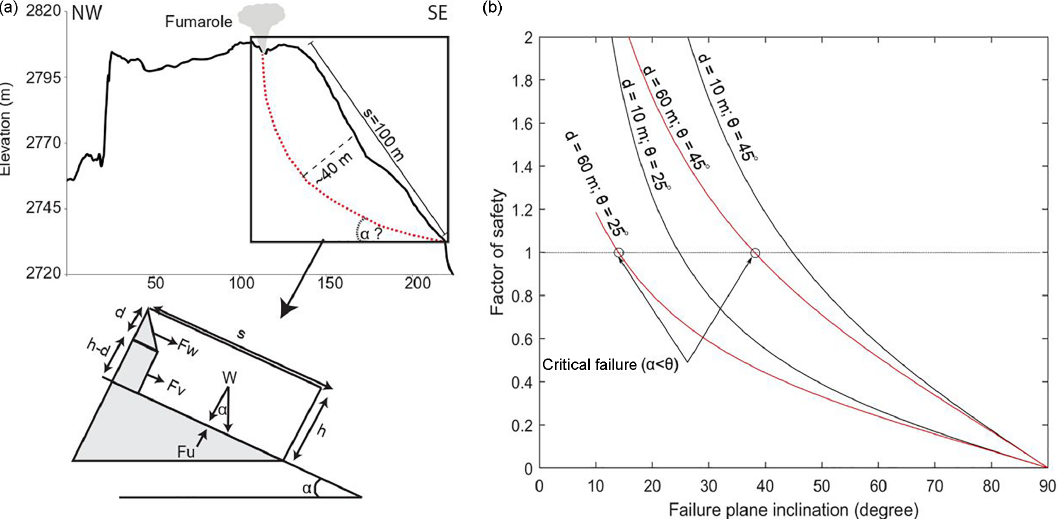
Figure 7. (a) Cross section of the Merapi lava dome shows that the horseshoe-shaped structure may develop into a translational fault with fracture spacing ( s ) up to 100m and a hanging wall thickness of ∼ 40m. The stability of the unstable dome sector is influenced by the weight ( W ), water force ( F W ), vaporized water force ( F V ) and gas uplift force ( F u ) along the fault boundary during intense rainfall (Modified from Simmons et al., 2004). (b) Analysis of factor of safety for the southern dome sector shows that deep water percolation (red lines) may reduce failure plane inclination and failure may occur even if the failure plane is inclined gently below the friction angle ( α<θ